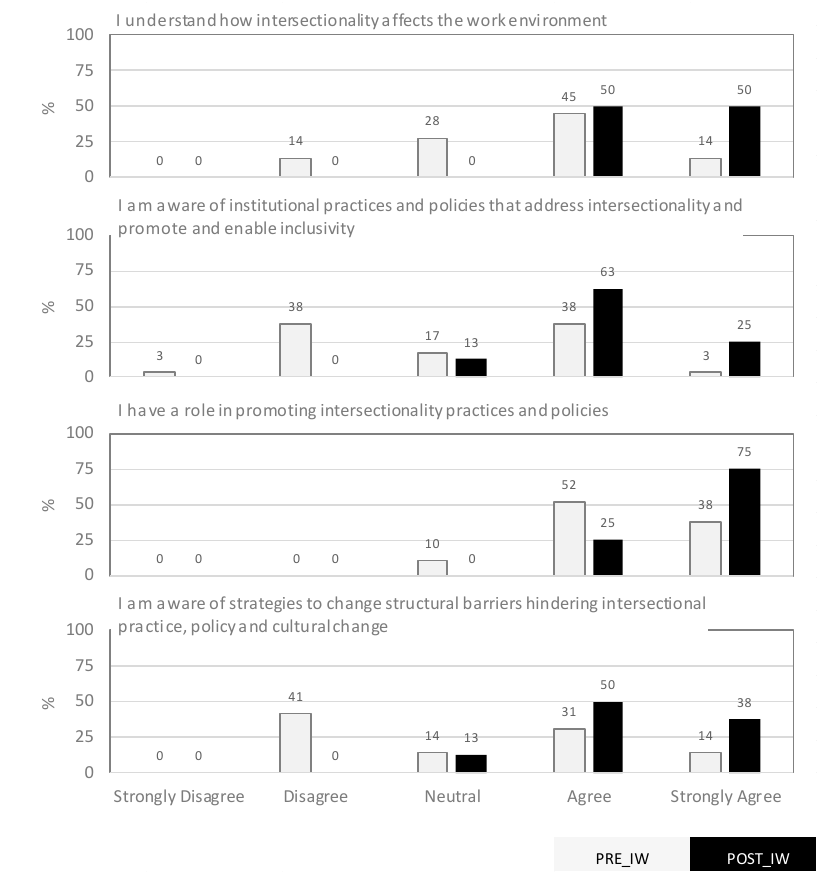
Figure 3. Intersectionality Walk participant survey responses reflection their view of institutions, before and after the IW. Survey responses are shown as % positive responses for each category. PRE_IW denotes before the IW (N = 29), POST_IW denotes after the IW (N = 8).